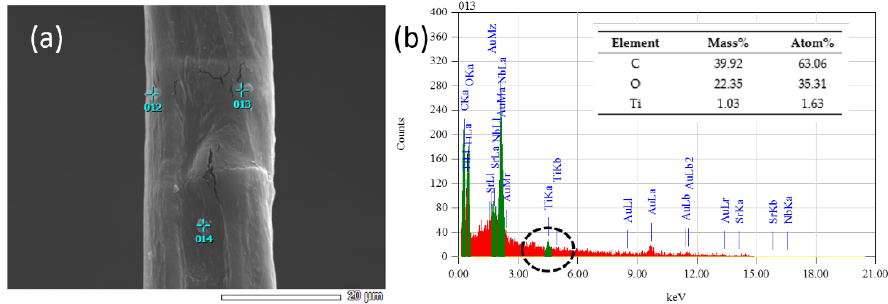
Figure 6. ( a ) SEM images ofCF-TiO 2 ; ( b ) EDX-mapping images of CF-TiO 2 .